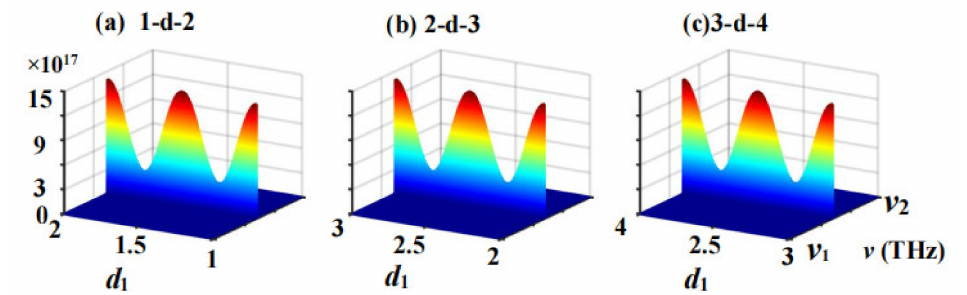
Figure 4. Intensity map of the photonic location of the 1D SPROWN of G = 1 and η = 5,determined by the first extremum spontaneous PT-symmetric breaking point, where i-d-j ( i , j = 1,2,3) indi- cates the upper (lower) arm waveguide between nodes i and node j , ν 1 = 193.415785719THz, ν 2 = 193.41578571906THz: ( a ) the intensity distribution pattern in the 1- d -2 waveguide in Figure 1; ( b ) the intensity distribution pattern in the 2- d -3 waveguide in Figure 1; ( c ) the intensity distribution pattern in the 3- d -4 waveguide in Figure